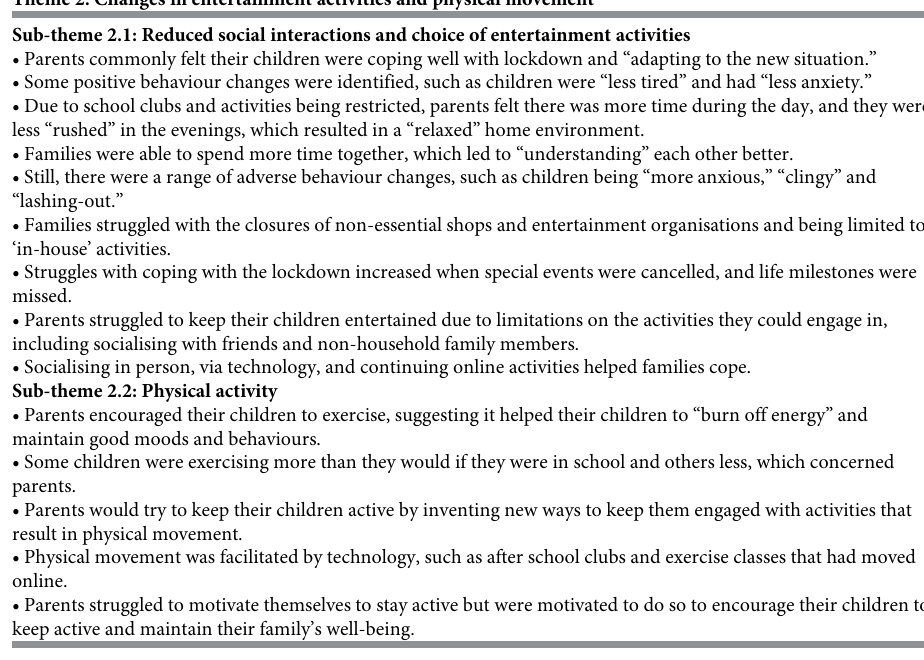
Table 3. The factors that affected how families coped with the COVID-19 school closures and lockdown measures in relation to Theme 2: Changes in entertainment activities and physical movement. Theme 2: Changes in entertainment activities and physical